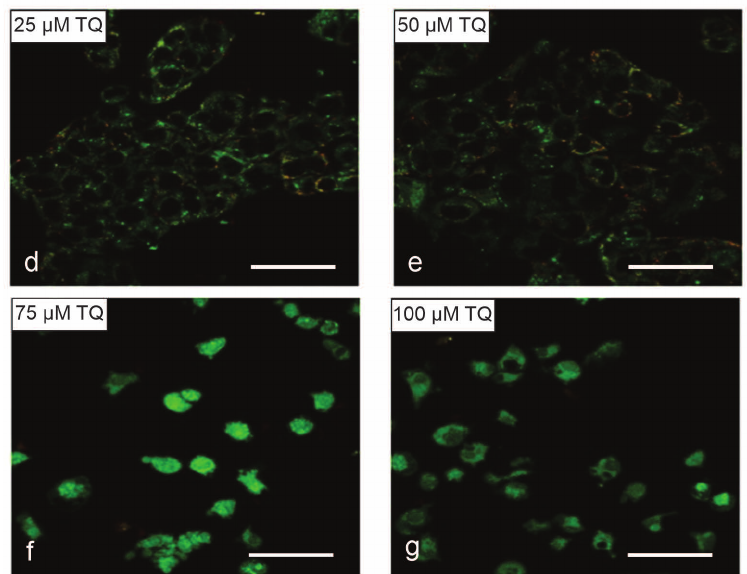
Figure 8. MMP disruption in HepG2 cells following exposure to TQ for 24 h (scale bar: 50 µ m). MMP was evaluated using JC-1 by image techniques in the cancer cells after being exposed to 0–100 µ M TQ: 0 µ M TQ ( a ) and DMSO ( b ), and 10 ( c ), 25 ( d ), 50 ( e ), 75 ( f ), and 100 µ M ( g ) TQ. The best representative Int. J. Mol. Sci. 2022 , 23 , x FOR PEER REVIEW images of each group are shown.